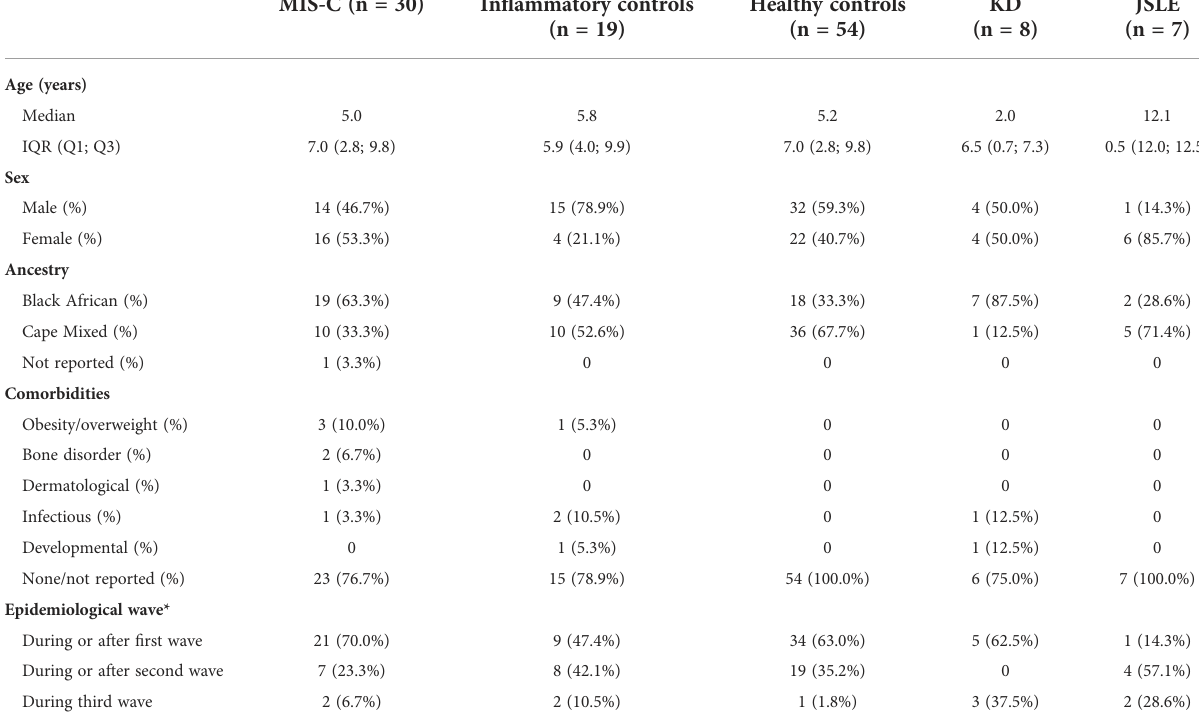
TABLE 1 Baseline characteristics of the MIS-C and control qPCR